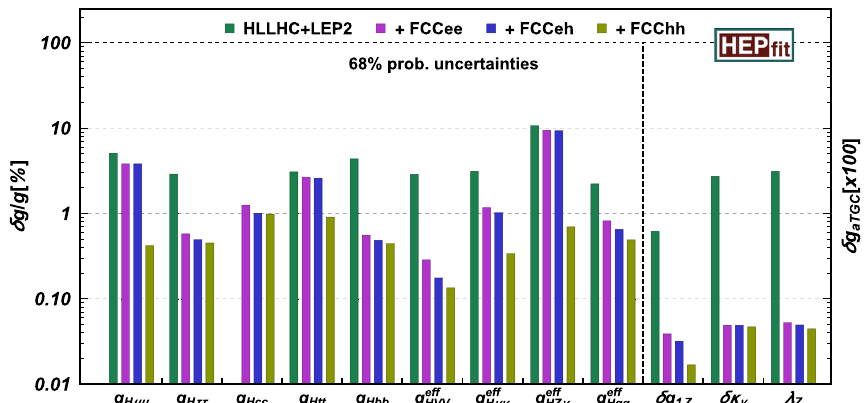
Fig. 8.4 One-sigma precision reach at the FCC on the effective single Higgs couplings and aTGC. An absolute precision in the EW measure- ments is assumed. The different bars illustrate the improvements that would be possible by combining each FCC stage/collider with the pre- vious knowledge at that time (the precisions, not reported here, at each